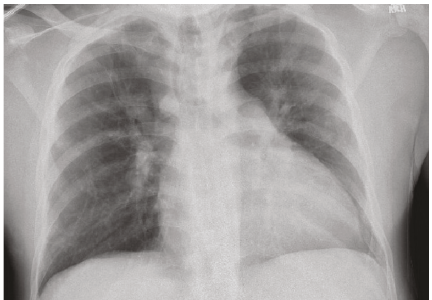
Figure 2: Chest radiograph from time of acute chest syndrome